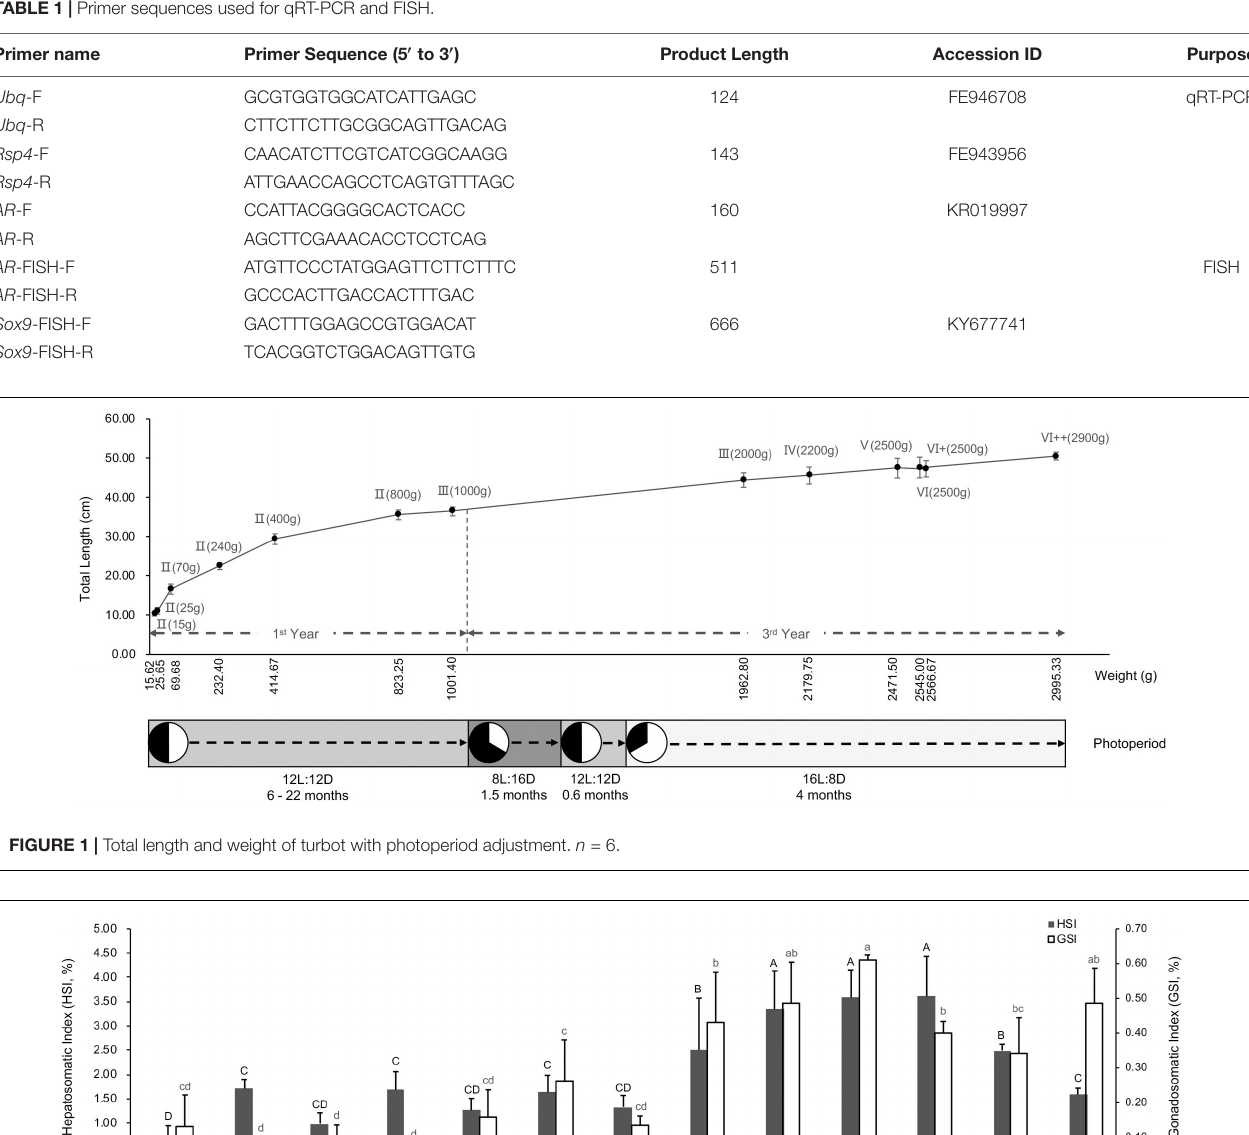
TABLE 1 | Primer sequences used for qRT-PCR and FISH.